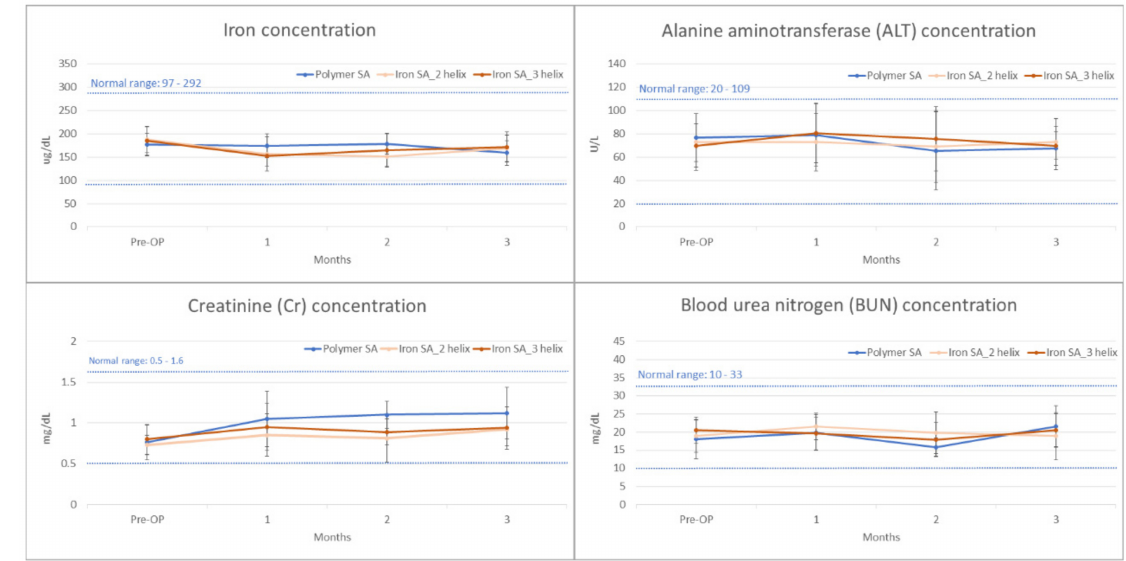
Figure 6. Blood concentrations of iron ( µ g/dL), alanine transaminase (ALT; U/L), creatinine (Cr; mg/dL), and blood urea nitrogen (BUN; mg/dL) preoperatively and 1, 2, and 3 months postoperatively. The error bar represented the standard